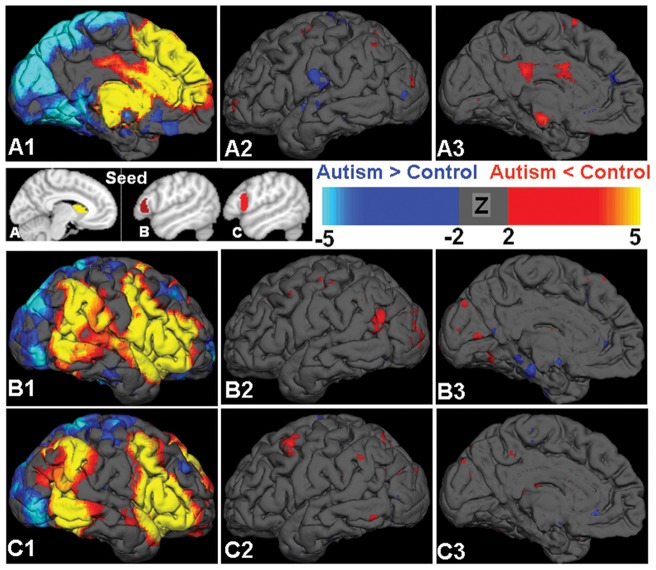
The functional connectivity network seeding from caudate and IFG region are demonstrated.In controls, the caudate-cortical network showed positive connections with the frontal and subcortical regions, and negative connections with the posterior visual and parietal areas (A1). The caudate-cortical network in children with ASD showed a primary reduction of cingulum and middle temporal connectivity (red color), but increased connectivity in several regions including the inferior and dorso-latero frontal areas (blue color, A2-A3). The functional connectivity network seeding from the IFG pars trianglaris in controls (B1) showed positive connections with the frontal and temporal regions and negative connections with the posterior visual and superior parietal areas. Difference of connectivity pattern comparing autism to controls seeded from pars trianglaris are shown in B2 and B3, with some reductions of visual and temporal connectivity in autism (red) and increments in the regions including medial temporal areas (blue). Functional connectivity seeding from IFG pars opercularis is shown in C1–C3, with primarily decreased connectivity in autism in the superior frontal regions. Seed regions are shown in the upper left images, and all statistical results were obtained with the threshold of minimal Z>2.3; cluster significance, P<0.05, corrected.